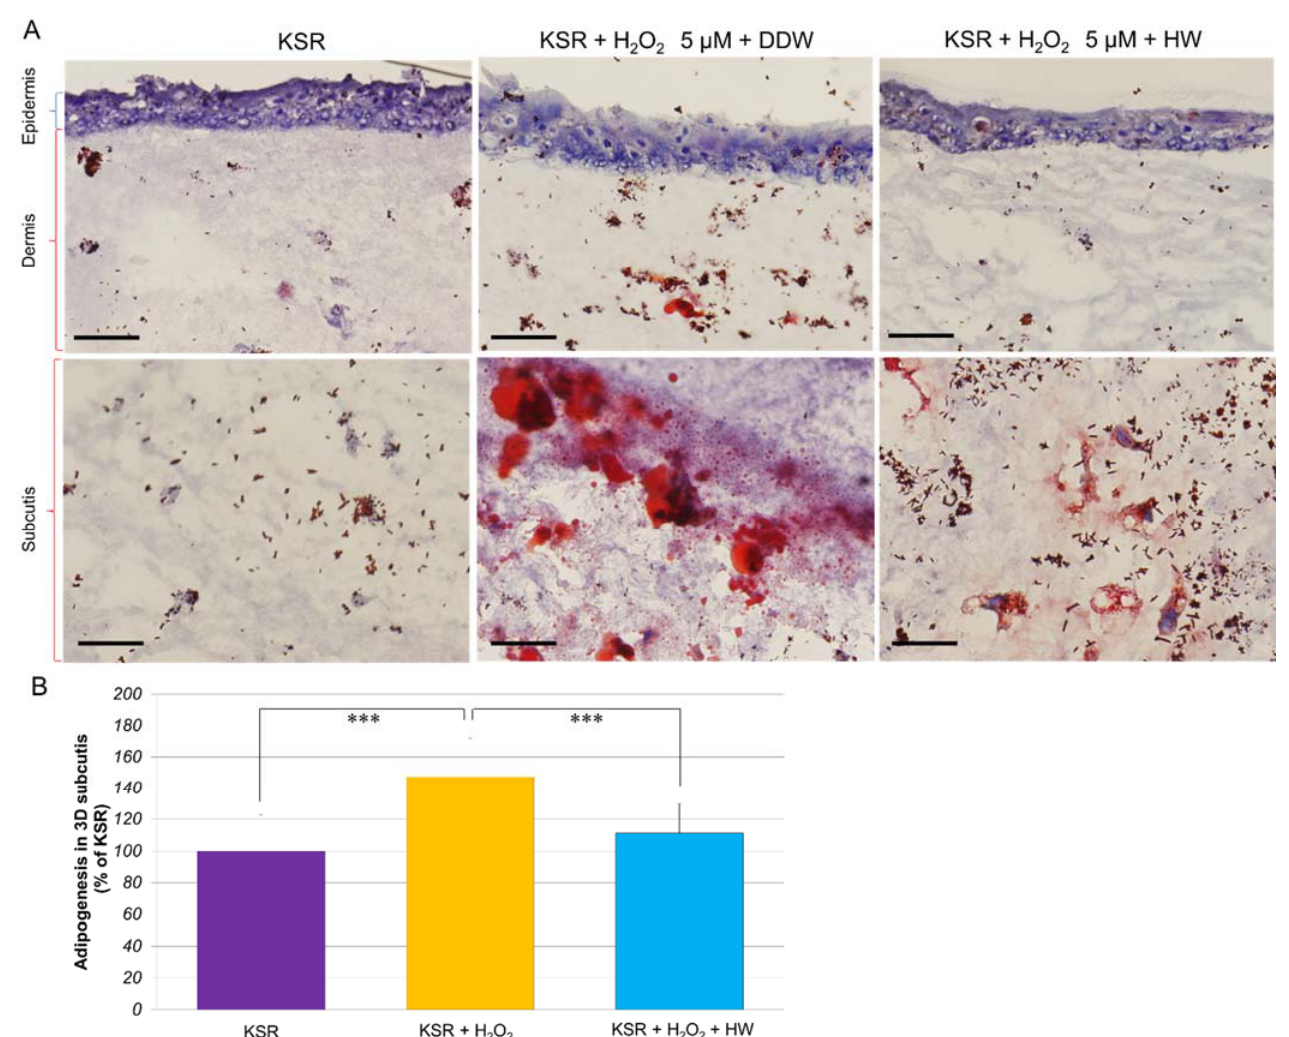
Figure 5. Repressive effects of HW on hydrogen peroxide-stimulated adipogenesis in 3D subcutaneous adipose equivalents. 3D equivalents were constructed as described in Materials and Methods. The 3D equivalents were cultivated in DDW- or HW-prepared KSR medium with or without H 2 O 2 (5 µM) for 4 days. At the end of cultivation, the tissue was fixed with 10% formalin and subjected to the frozen section. The lipid droplets were stained with Oil Red O dye. The images were taken by a microscope and analyzed with ImageJ software. ( A ) Typical images of Oil Red O staining. Blue, nuclei; red, lipid droplets. The scale bars indicate 100 µm in the upper panel and 50 µm in the lower panel, respectively; ( B ) data are expressed as a percent of KSR, and each concentration point and bar represent the mean ± SD of five independent experiments. *** p < 0.001.